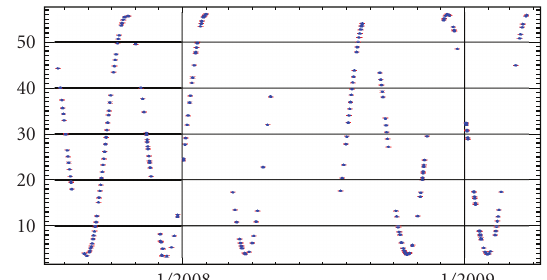
Figure 10: Radial velocities for the primary giant of the Capella binary system. Note that the orbital period is 104 days and that the total time coverage is three years. Gaps are mostly due to the observing season but also due to the various weather-related and technical down times.